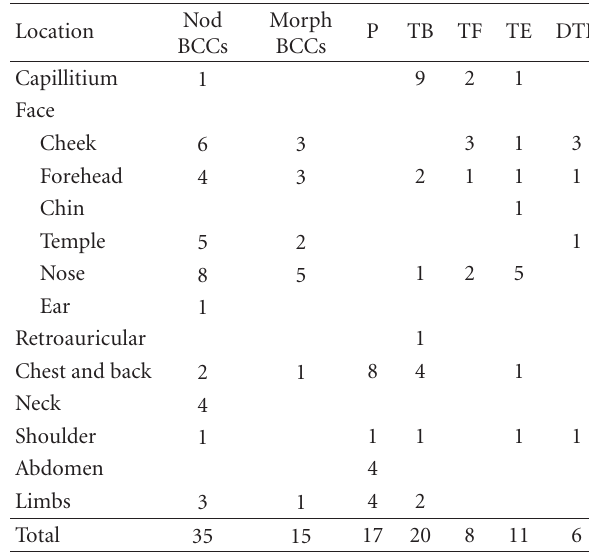
Table 2: Location of tumors.